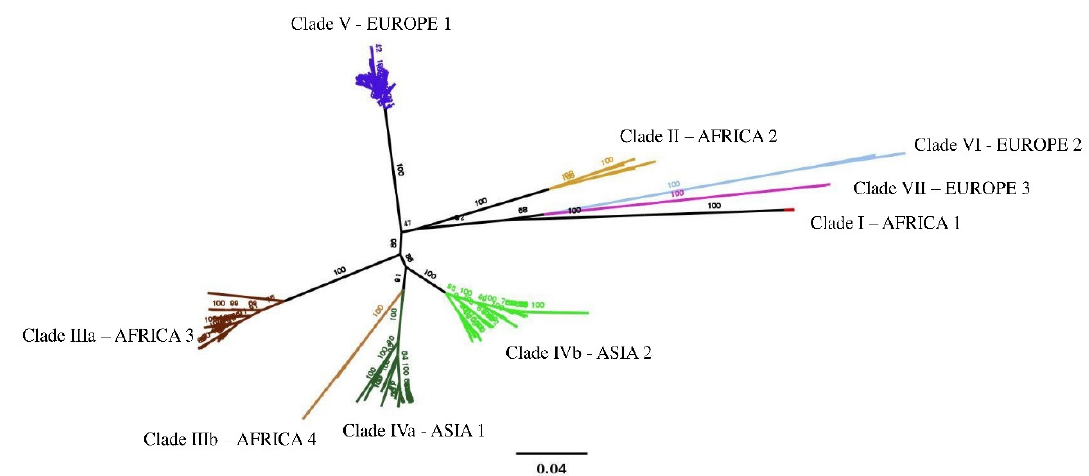
Figure 2. Maximum Likelihood Phylogenetic tree for complete S segment of CCHFV. Branches belonging to different clades are presented in different colors. Clade separation was adopted, in agreement with previous works (see Results), on the basis of collection countries and phylogeny. Asia